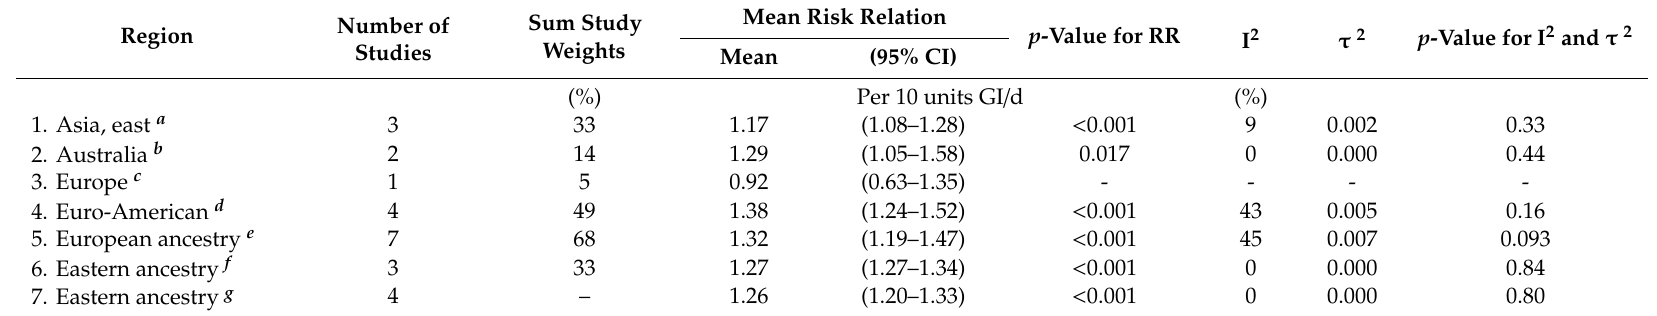
Table 3. Dose-response T2D–glycemic index risk relations by study region or ethnicity or ancestry for CORR >